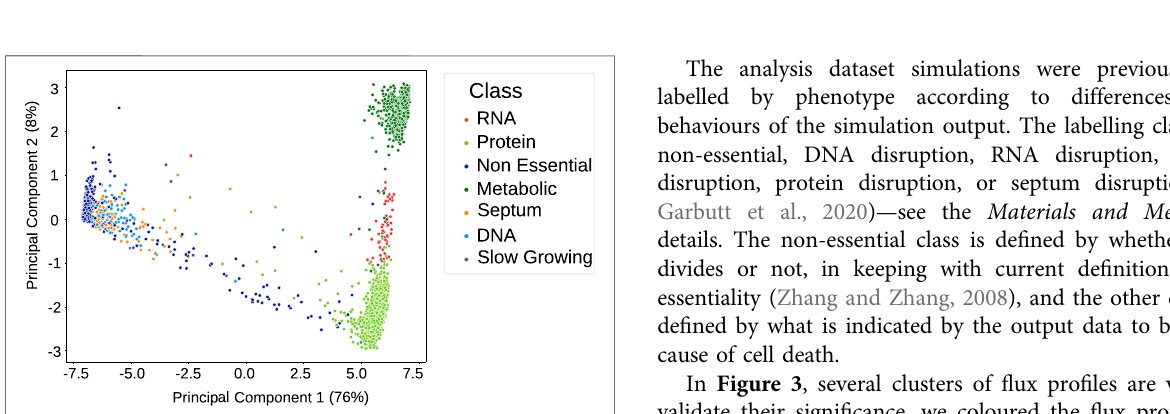
FIGURE 2 | Method of feature extraction and normality classi fi cation shown graphically. The features shown in plot (A) were taken, and principal component analysis (PCA) was applied for each reaction fl ux in each simulation across the dataset to create plot (B) , retaining 82.9% of the variance. The wild-type simulations are showninblue,andthenthreeboundariesareshown(extrema,99%con fi denceintervals,and95%con fi denceintervals),whichareusedtoformthreelabellingschemes.